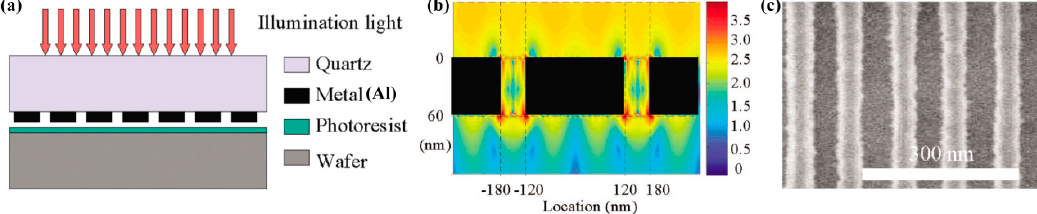
7 of 32 Figure 6. ( a ) Top panel is the calculation of optical transmission function (OTF) for SiO 2 /Al films with variant thickness by RCWA and EMT. Middle and bottom panels are the real and imaginary part of k z for variant k x calculated by Bloch theorem without considering the Al absorption. OTF plots in logarithm scale as function of ( b ) unit thickness d and ( c ) metal film filling factor f . Reproduced from [37]. Copyright © 2015, WILEY. 3. Plasmonic Interference Lithography Laser interference lithography (LIL) is a popular nanofabrication method due to its maskless, low-cost, parallel and large-area features, and it has attracted a great deal of interest and shows promising application in manufacturing a great variety of functional structures with periodical nano patterns [45], like hologram gratings, nano pillar arrays, two dimensional (2D) and three-dimensional (3D) photonic crystal structures, biosensors, etc. Suffering from the diffraction limit, the half-pitch resolution of conventional LIL is theoretically restricted as one quarter of the light wavelength. Light sources with shorter wavelength, like DUV, EUV and even soft x-ray, could achieve much smaller interference patterns, but the expensive laser setups and complex processing hampers their practical applications for common researchers. 3.1. SPPs Interference Lithography SPPs could be manipulated with a propagation wavelength much shorter than that of the same- frequency light in dielectric. This feature could be readily explored for subwavelength interference lithography. In 2004, aluminum grating with a 300 nm period and 50 nm wide slot was used to excite SPPs under 436 nm wavelength light, forming about 100 nm period interference lines inside resist beneath the grating (Figure 7) [21,46]. Further, a reflective cladding metal slab below the resist layer is proposed to generate high contrast interference fringes of coupled SPP waves [47,48]. To get SPP interference patterns beneath the grating structures with acceptable uniformity, the grating structure for SPPs’ excitation should be carefully designed to be compatible with the SPP mode. By imposing two or multiple gratings, SPPs’ interference beyond the diffraction limit could also be realized in the central region (Figure 8a–d) [49–51]. However, the interference pattern area